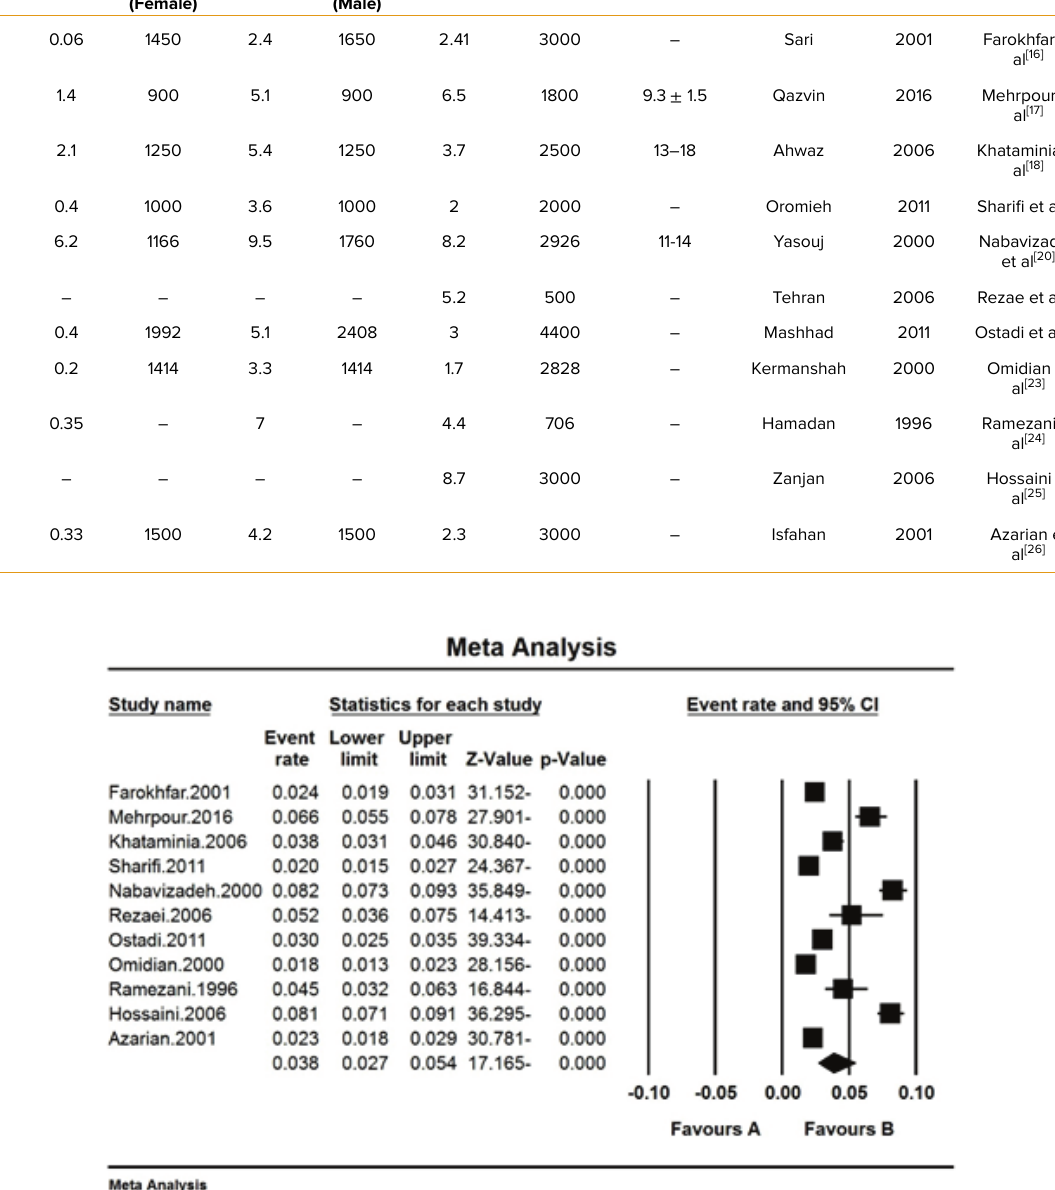
Figure 2. The prevalence of color blindness in Iranian